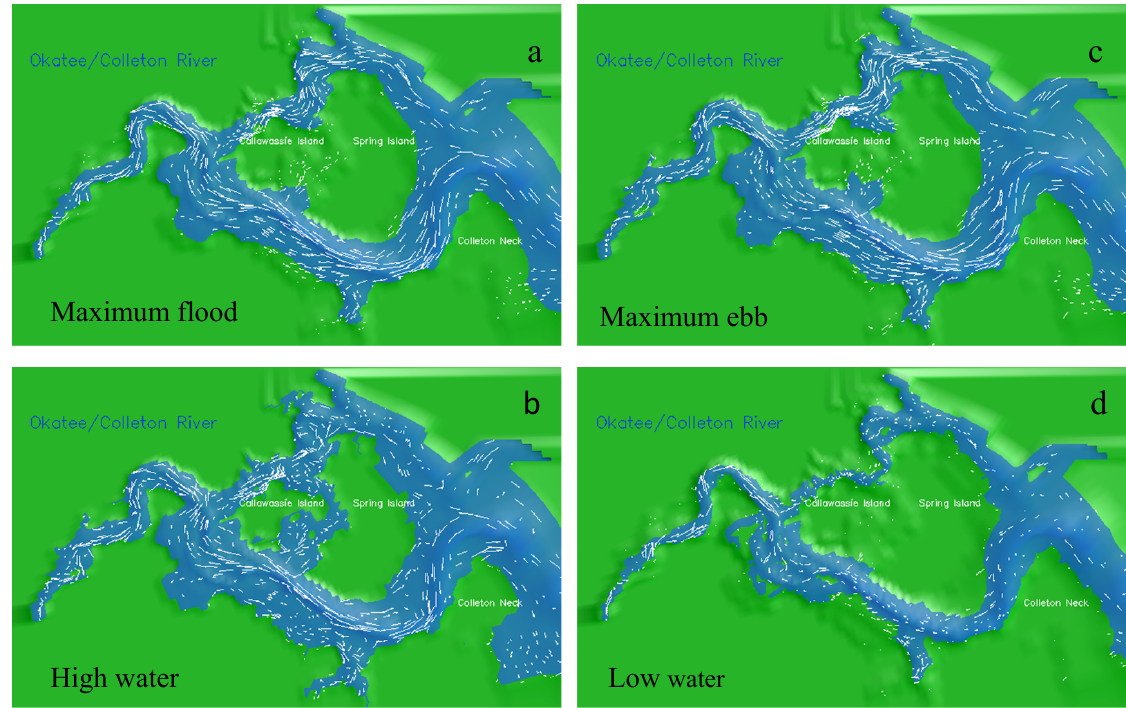
Figure 9. Distributions of the model-predicted sea level and vertically averaged tidal current vectors at the maximum flood ( a ), flood to ebb (high water) ( b ), the maximum ebb ( c ), and ebb to flood (low water) ( d ). These four images were subtracted from the animation film made by the 3D graphics software in which the velocity vector was superposed over the sea level. The vectors shown in the dry area were caused by the improper setup of the velocity in the graphics of this software rather than predicted by the model. For a clear view, the animation can be accessed at http://fvcom.smast.umassd.edu/ 2014/01/14/4-research-okateecollecton-river/ (accessed on 5 July 2022).